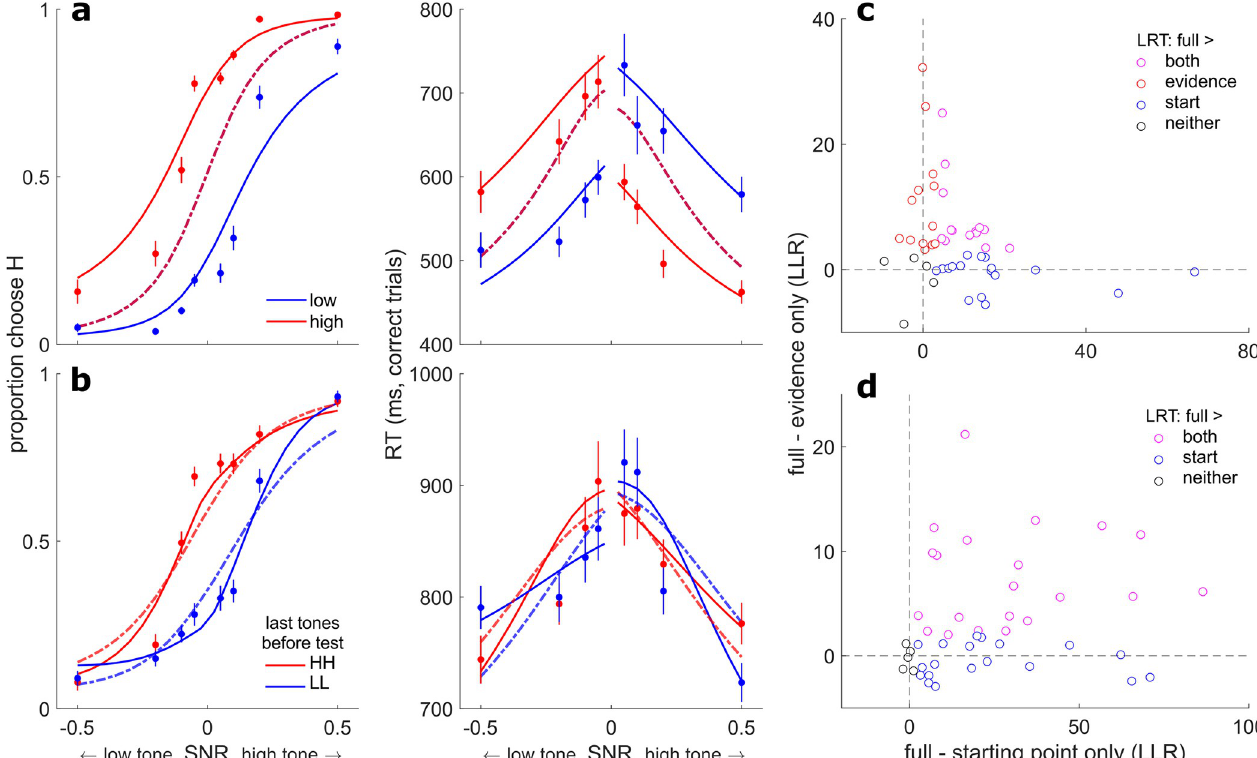
Fig 5. Comparing full and reduced model fits. A DDM fits to the rule-based condition for the base model, with no cue-dependent bias terms (dashed lines; note the overlapping lines), and the full model, with bias terms (solid lines). B DDM fits to the stimulus-based condition for the bias-only model (dashed lines) and full model (solid lines). C The difference in fit (log-likelihood ratio [LLR]) for the rule-based full model vs. evidence-only model (ordinate) and full model vs. starting-point-only model (abscissa), plotted per subject (points). D same as C , for the stimulus-based condition. In A and B , points are averages over subjects’ data, and error bars are SEM. Fewer cue conditions are plotted than in Fig 2 to facilitate visual comparison between the full and reduced models. In C and D , data points are colored according to the model preferred from per-subject likelihood-ratio tests (LRT) between the full and reduced (evidence-only or starting-point-only) models (see legend). Negative LLRs are due to imprecisions in the fits caused by local minima near the global solution, which we confirmed by rerunning a subset of the full model fits with an expanded search of the parameter space and stricter stopping criteria. See S2 Fig for fits to the RT distributions for the full